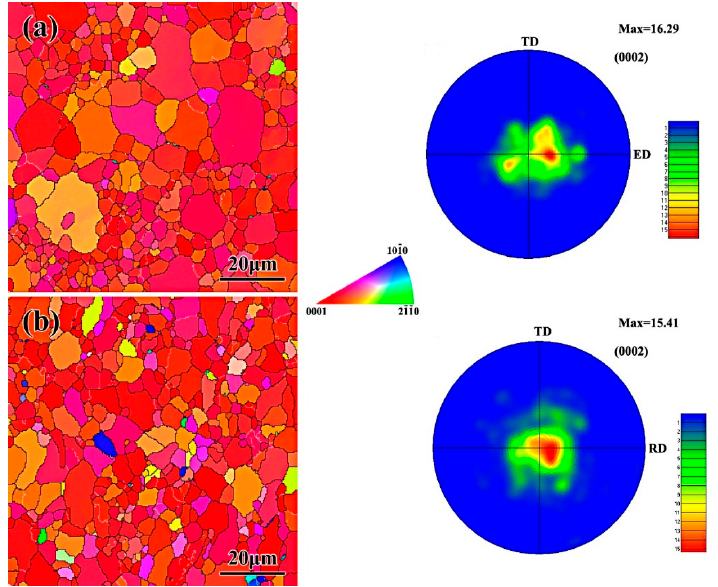
Figure 6. Inverse pole figure (IPF) map and (0002) pole figure of ( a ) extruded and ( b ) rolling-annealed sample annealed at 250 °C for 30 min.